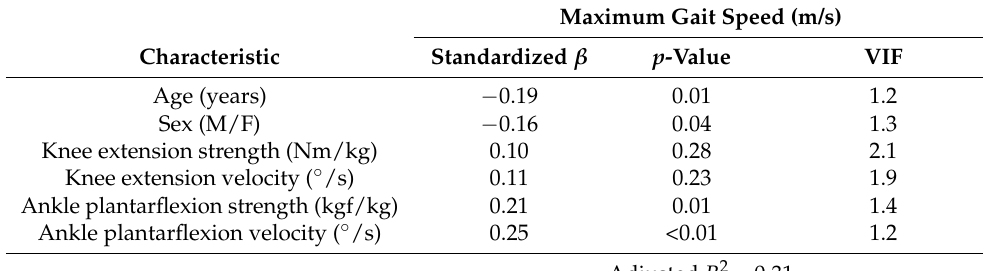
Table 3. The results of multiple regression